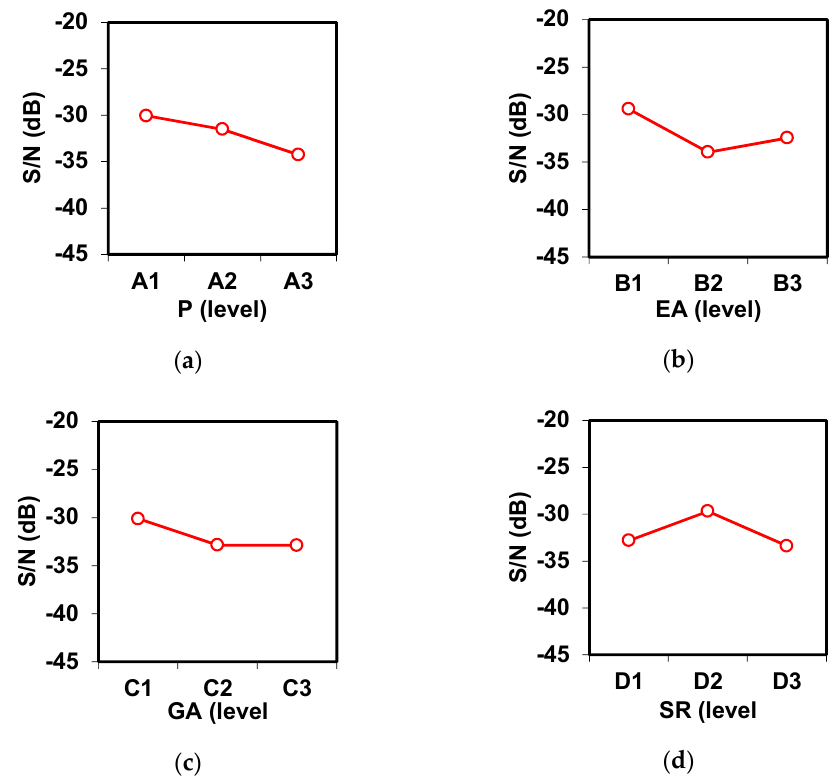
Figure 8. Individual influence of factors on the temperature at 5 mm, S/N obtained for the three leves of ( a ) Power ( b ) Excess Air ( c ) Grate Area ( d ) Split Ratio.